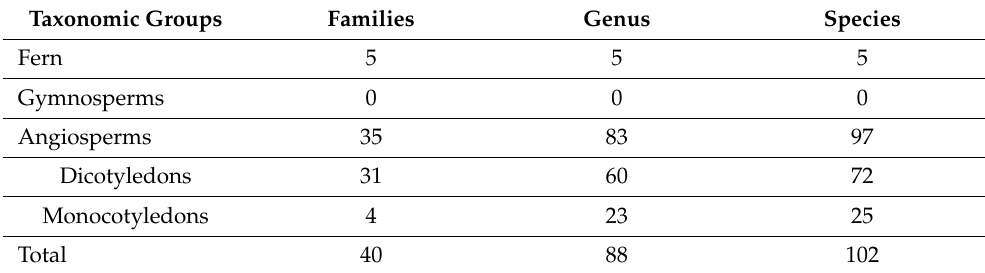
Table 1. Main plant species taxonomic group characteristics of current habitats in the project area.